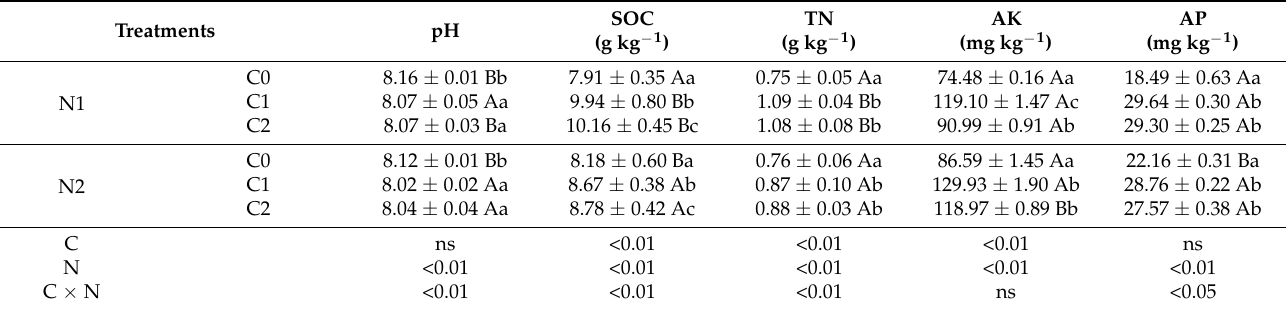
Table 1. Results of two-way ANOVA for soil physiochemical